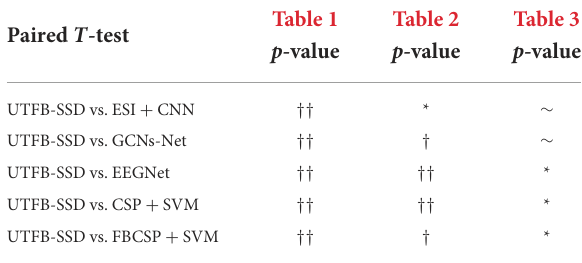
TABLE 4 T -test results for the proposed method vs. competing